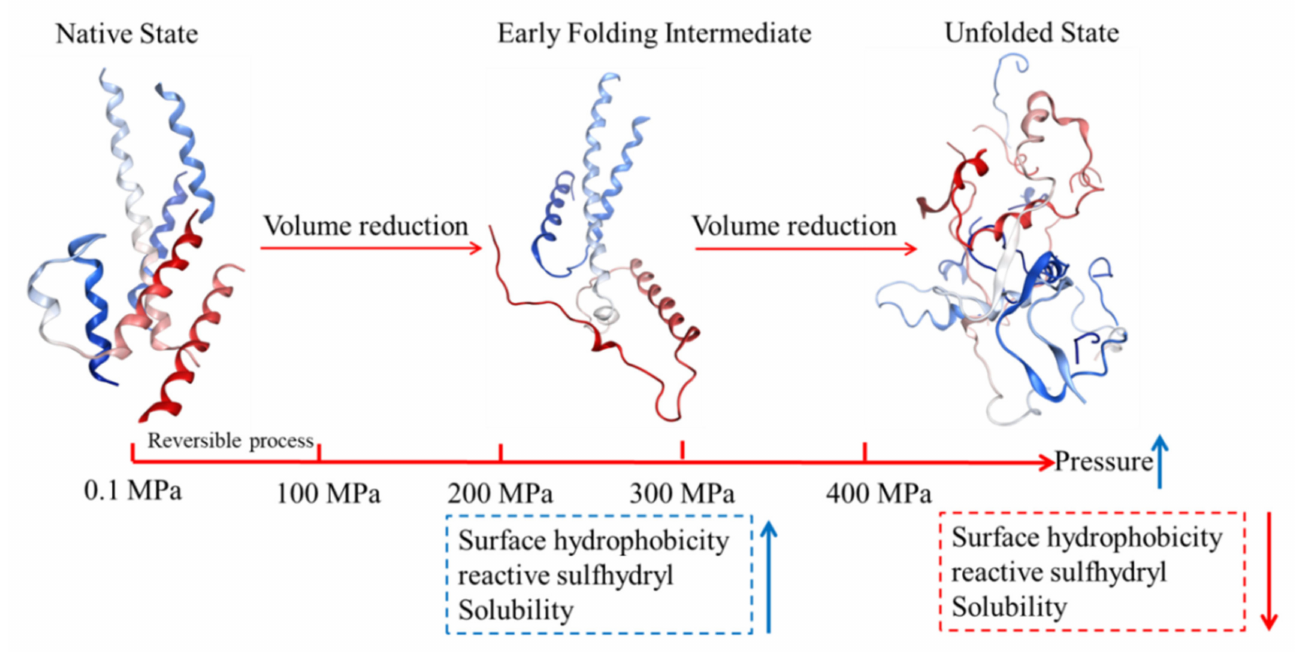
Figure 1. Schematic diagram of the mechanism of pressure-induced protein